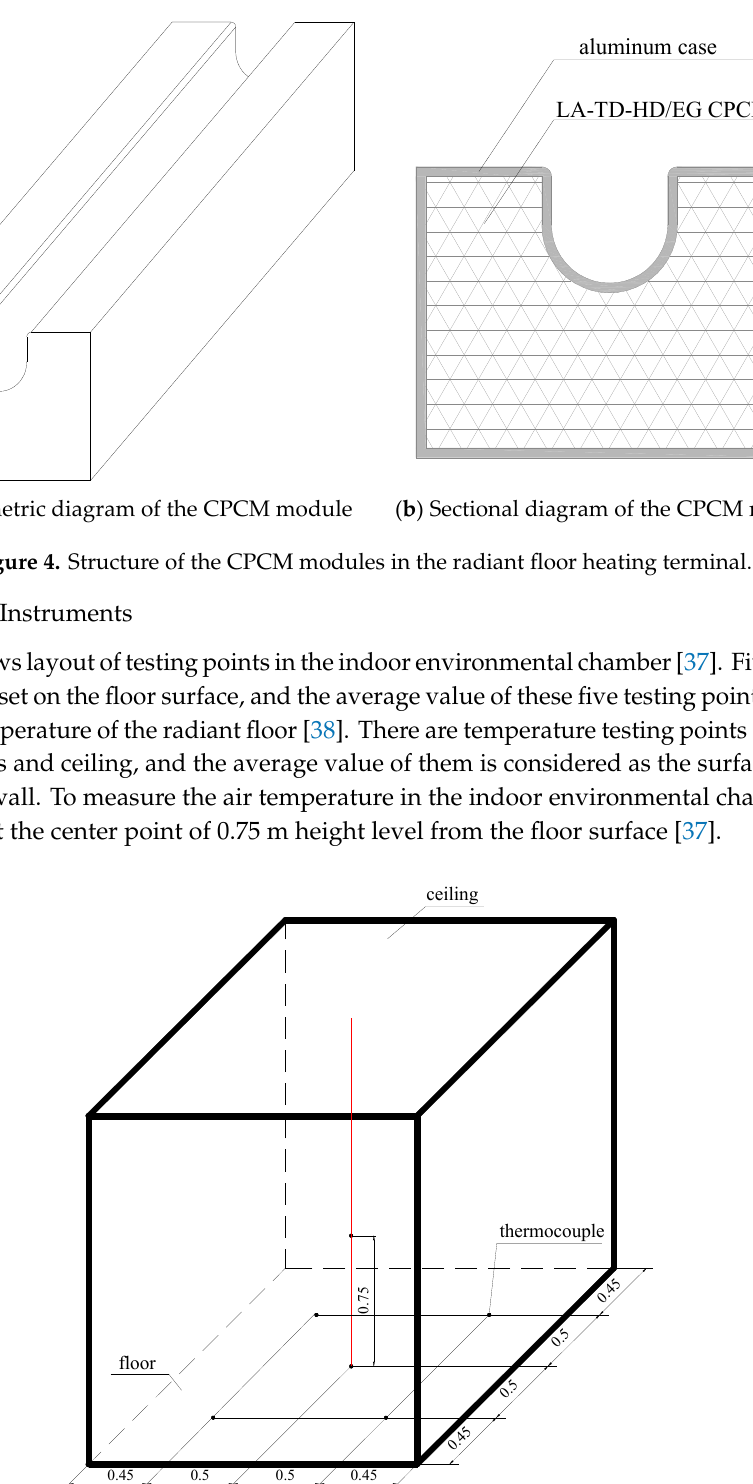
Figure 3. Photographs of the experimental heating terminal structure.